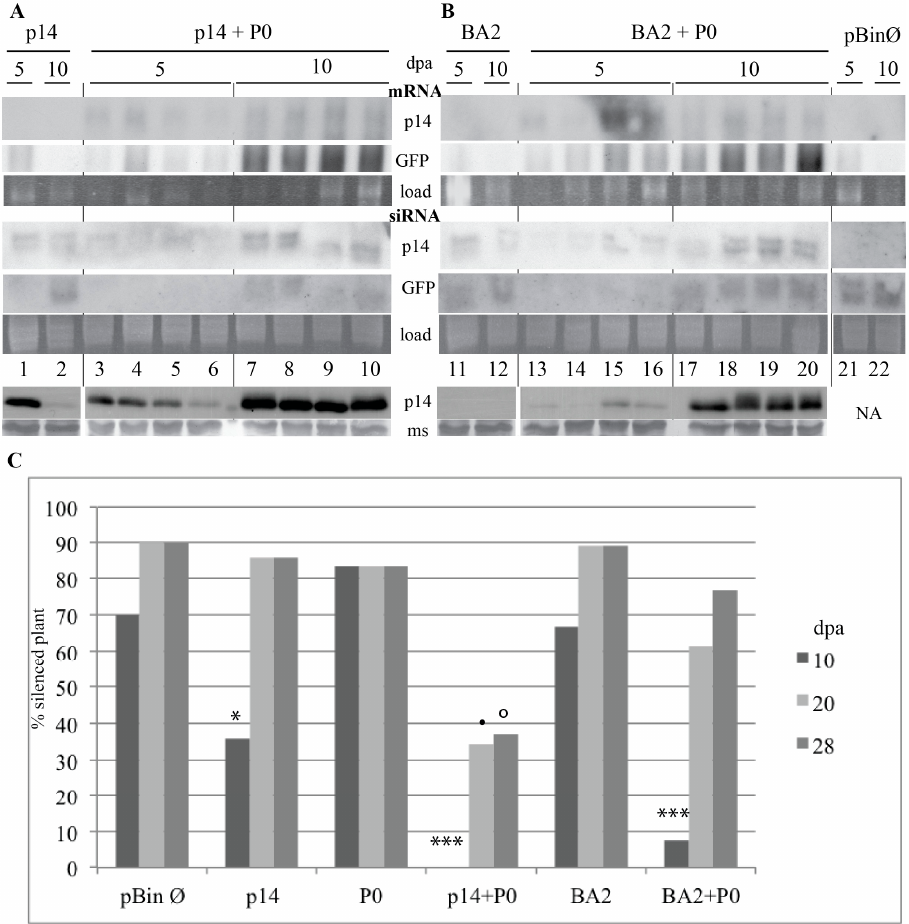
Figure 5. Stabilization of BNYVV VSR ectopic expression reveals its inhibitory effect on systemic movement of RNA silencing in N. benthamiana 16C. The expression of p14 in patch tests leads to poor expression, while their co ‐ expression with P0 stabilizes the mRNA and maintains p14 protein function. Plants were infiltrated with a mixture of Agrobacterium tumefaciens bacteria carrying a binary vector allowing the expression of the GFP trigger and p14 ( A ) or its mutant BA2 ( B ) alone (lanes 1–2 and 11–12, respectively) or with turnip yellows virus P0 (p14 + P0, lanes 3–10; BA2, lanes 13–20) or in the presence of the empty vector ( B , pBinØ lanes 21–22). Individual patches were collected at 5 and 10 days post ‐ agroinfiltration (dpa) from infiltrated areas. p14, BA2, and GFP mRNA (upper panels) and siRNA accumulations (middle panels) were tested via Northern blot. p14 and BA2 were detected via Western blot (lower panels). Total proteins were visualized by membrane staining (ms). Spaces between lanes 6–7 and 16–17 correspond to molecular weight markers positions. RNA loading is visualized by ethidium bromide staining (load); ( C ) The histogram represents the percentage of plants systemically silenced for each combination. The systemic movement of RNA silencing was assessed under an ultraviolet (UV) lamp using plants infiltrated with empty vector (Ø, 4 experiments, 10 plants) as a control after 10, 21, and 28 days. Systemic silencing was delayed in the presence of p14 + P0 (4 experiments, 25 plants) and started to appear for some of the plants at 20 dpa and thus differed from p14 (4 experiments, 12 plants) or P0 (3 experiments, 9 plants) alone (p14 + P0, 20 dpa; p ‐ value < 0.05). The stabilization of p14BA2 (3 experiments, 13 plants) decreased systemic silencing compared with BA2 (3 experiments, 9 plants) or P0 alone, and few plants started to present systemic silencing after 10 days (BA2 + P0, 10 dpa; p ‐ value < 0.001). After 20 days, systemic silencing was as the controls (BA2 + P0, 20/28 dpa; p ‐ values > 0.3 compared with P0 or BA2 alone). Statistical analyses were performed using Fisher’s exact test. The p ‐ values were obtained using the false discovery rate method. (*, •, and o correspond to 10, 20, and 28 dpa, respectively). p ‐ value < 0.05 and *** p ‐ value < 0.001. NA: not applicable.